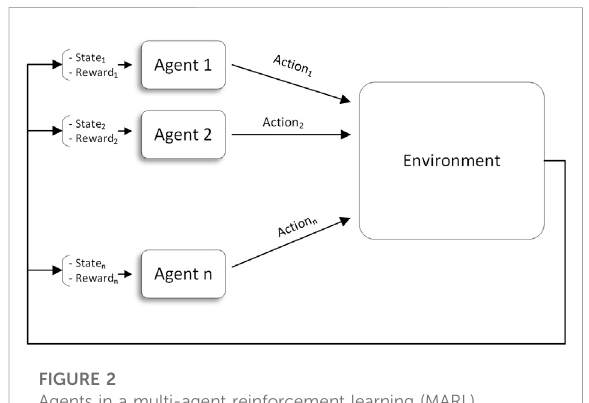
FIGURE 3 JAL (Nowé et al. (2012)).